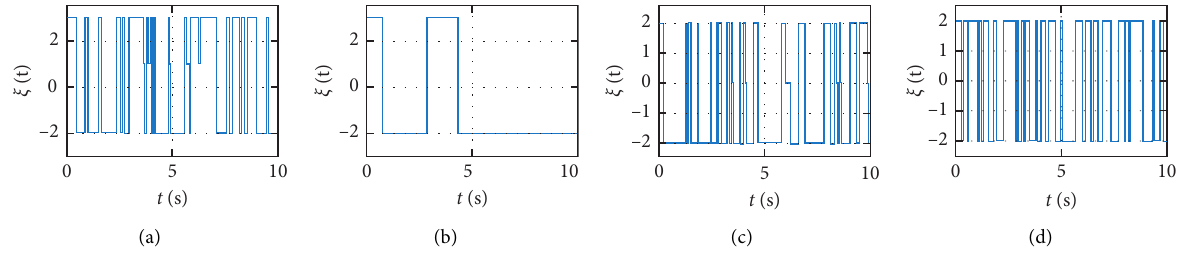
Figure 2: (a, b) The asymmetric trichotomous noise with parameters a � 3, b � 1, c � − 2. (a) D � 1, q � 0.3. (b) D � 4, q � 0.3. (c, d) The symmetric trichotomous noise with parameters a � 2, b � 0, c �− 2. (c) D � 0.5, q � 0.3. (d) D � 1, q � 0.5.